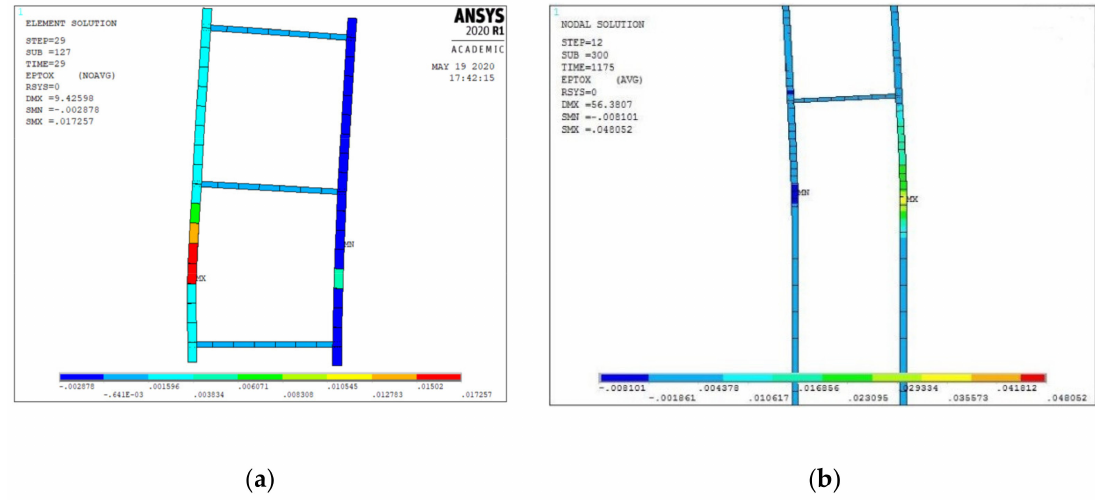
Figure 7. Strains in longitudinal bar: ( a ) control column, ( b ) strengthened with carbon